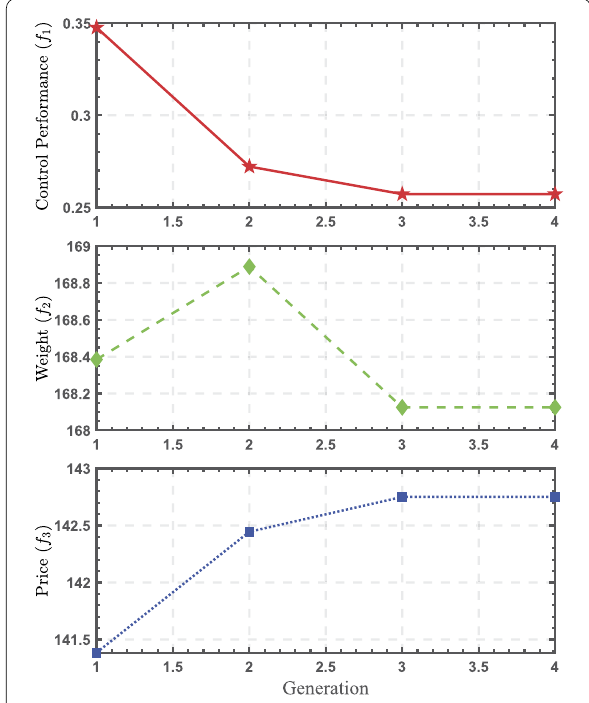
Figure 8 Mean values of the objective functions for solutions in the “excellent class”